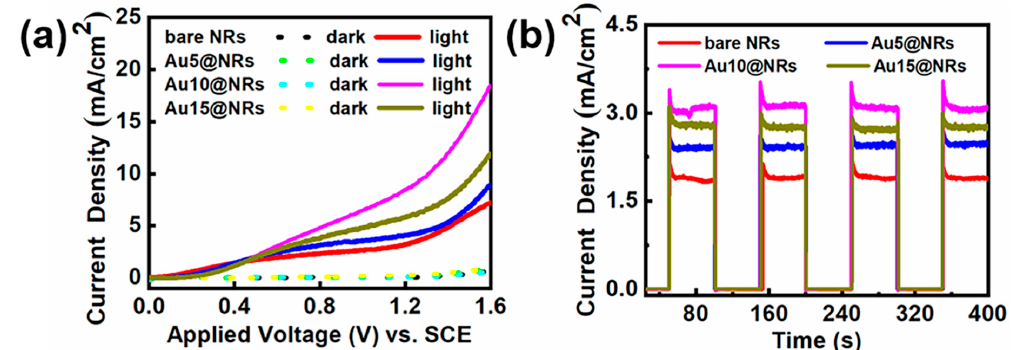
Figure 4. ( a ) Current–potential curves of the bare NRs, Au5@NRs, Au10@NRs, and Au15@NRs photoanodes in 0.5 M H 2 SO 4 solution in the dark and under 100 mW cm − 2 irradiation. ( b ) The amperometric I–t curves of the bare NRs, Au5@NRs, Au10@NRs, and Au15@NRs under chopped illumination at 0.6 V vs. reversible hydrogen electrode (RHE).